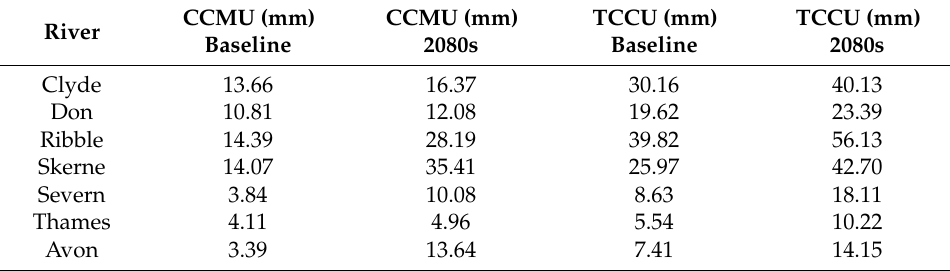
Figure 5. Step 3: Combined uncertainties for the GEV (grey shades) and GP (blue shades) models on the baseline (left) and the 2080s (right) on: ( a ) the Clyde River at Tulliford Mill; ( b ) the Don River at Parkhill; ( c ) the Ribble River at New Jumbles Rock; ( d ) the Skerne River at Preston le Skerne; ( e ) the Severn River at How Bridge; ( f ) the Thames River at Eynsham; and ( g ) the Avon River at Amesbury). Table 1. For each selected gauging station, on the baseline and the 2080s: combined GEV and GP model uncertainties related to the climate model (CCMU) and the total combined cascaded uncertainty